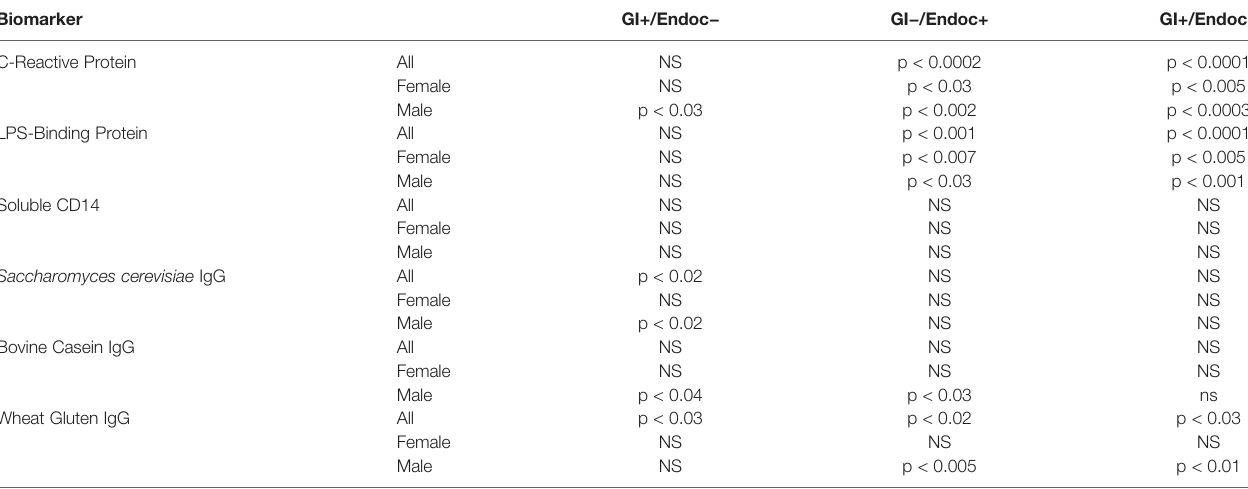
TABLE 3 | Comparison of biomarker levels by sex and by GI and endocrine comorbidity status.